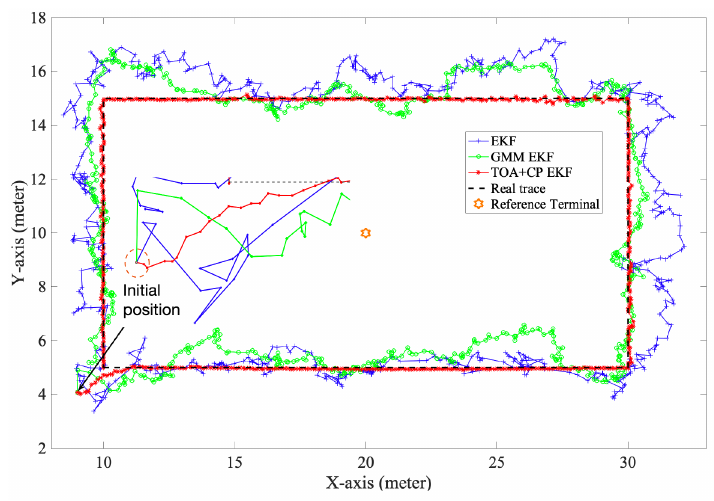
Figure 7. Localization performance of